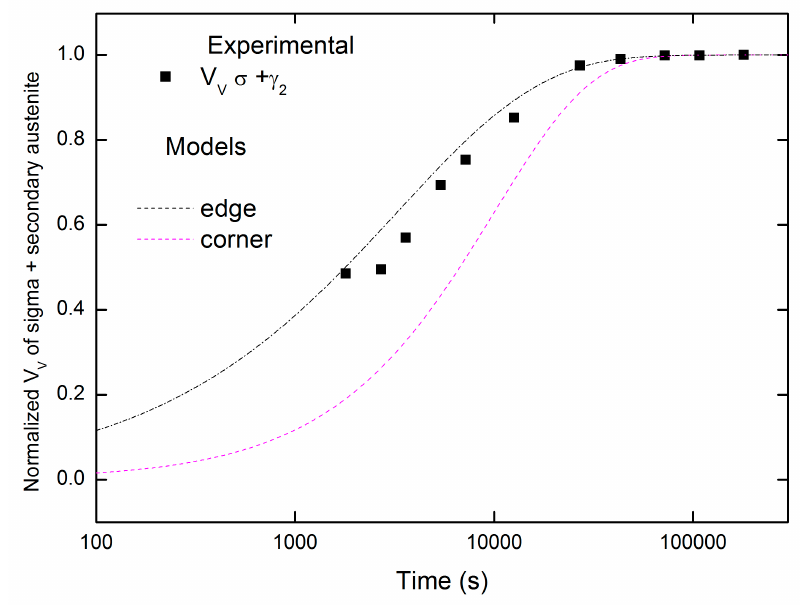
Figure 7. The normalized volume fraction of the sigma phase plus secondary austenite as a function of the aging time, at 750 °C. The dashed lines represent the fit of the experimental data to Equations (13) and (14), respectively (Cahn’s Model).